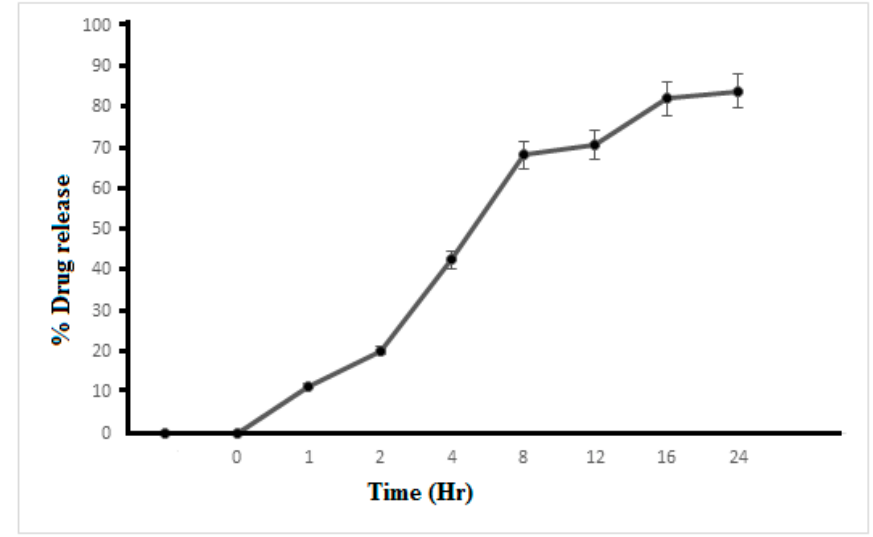
Figure 5. Percentage of release of KA from nanocrystals as a function of time.